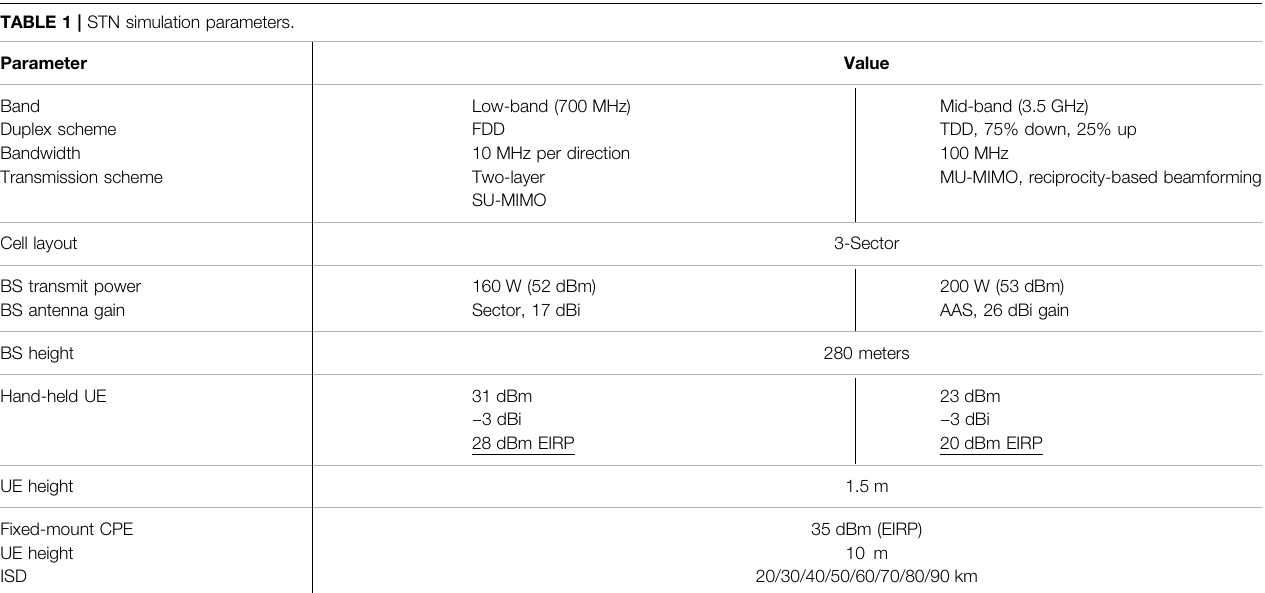
TABLE 1 | STN simulation